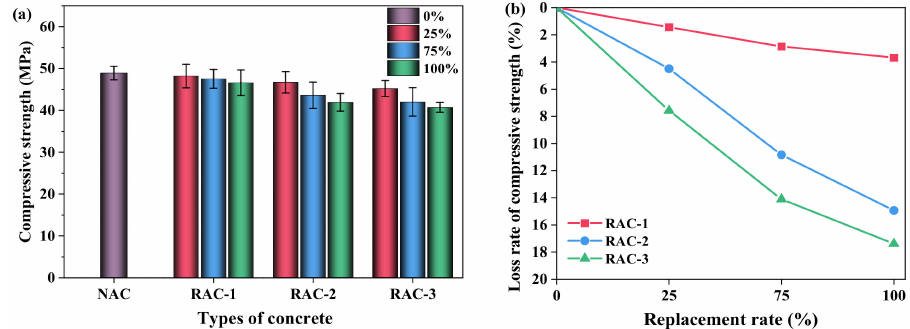
Figure 4. Compressive strength ( a ) and its loss rate ( b ) of RRAC at 28